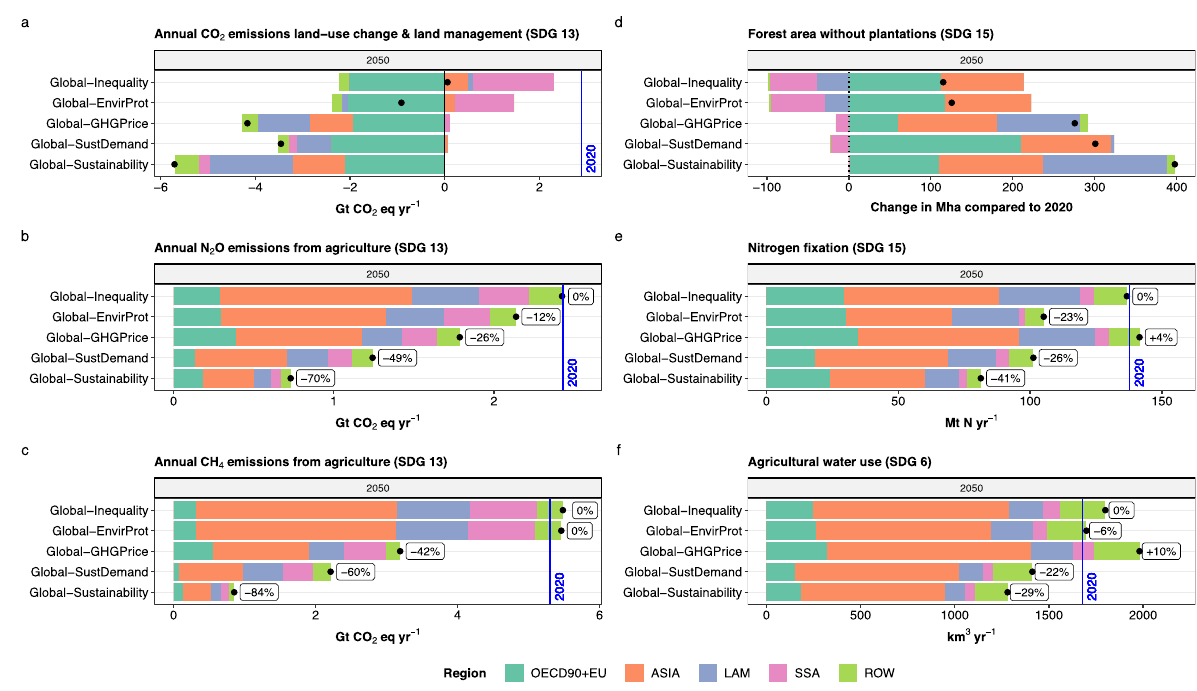
Fig. 3 | Summary of results for fi ve scenarios and six indicators (mapped to SDGs) for 2050 at regional and global level. a CO 2 emissions and removals from land-use change and management, b N 2 O emissions from agriculture, c CH 4 emissions from agriculture, d change inforest area without plantations, e nitrogen fi xation, and f agriculturalwateruse.Blackdots show the globalnet effect foreach indicator and scenario. Blue vertical lines show the respective value in year 2020.